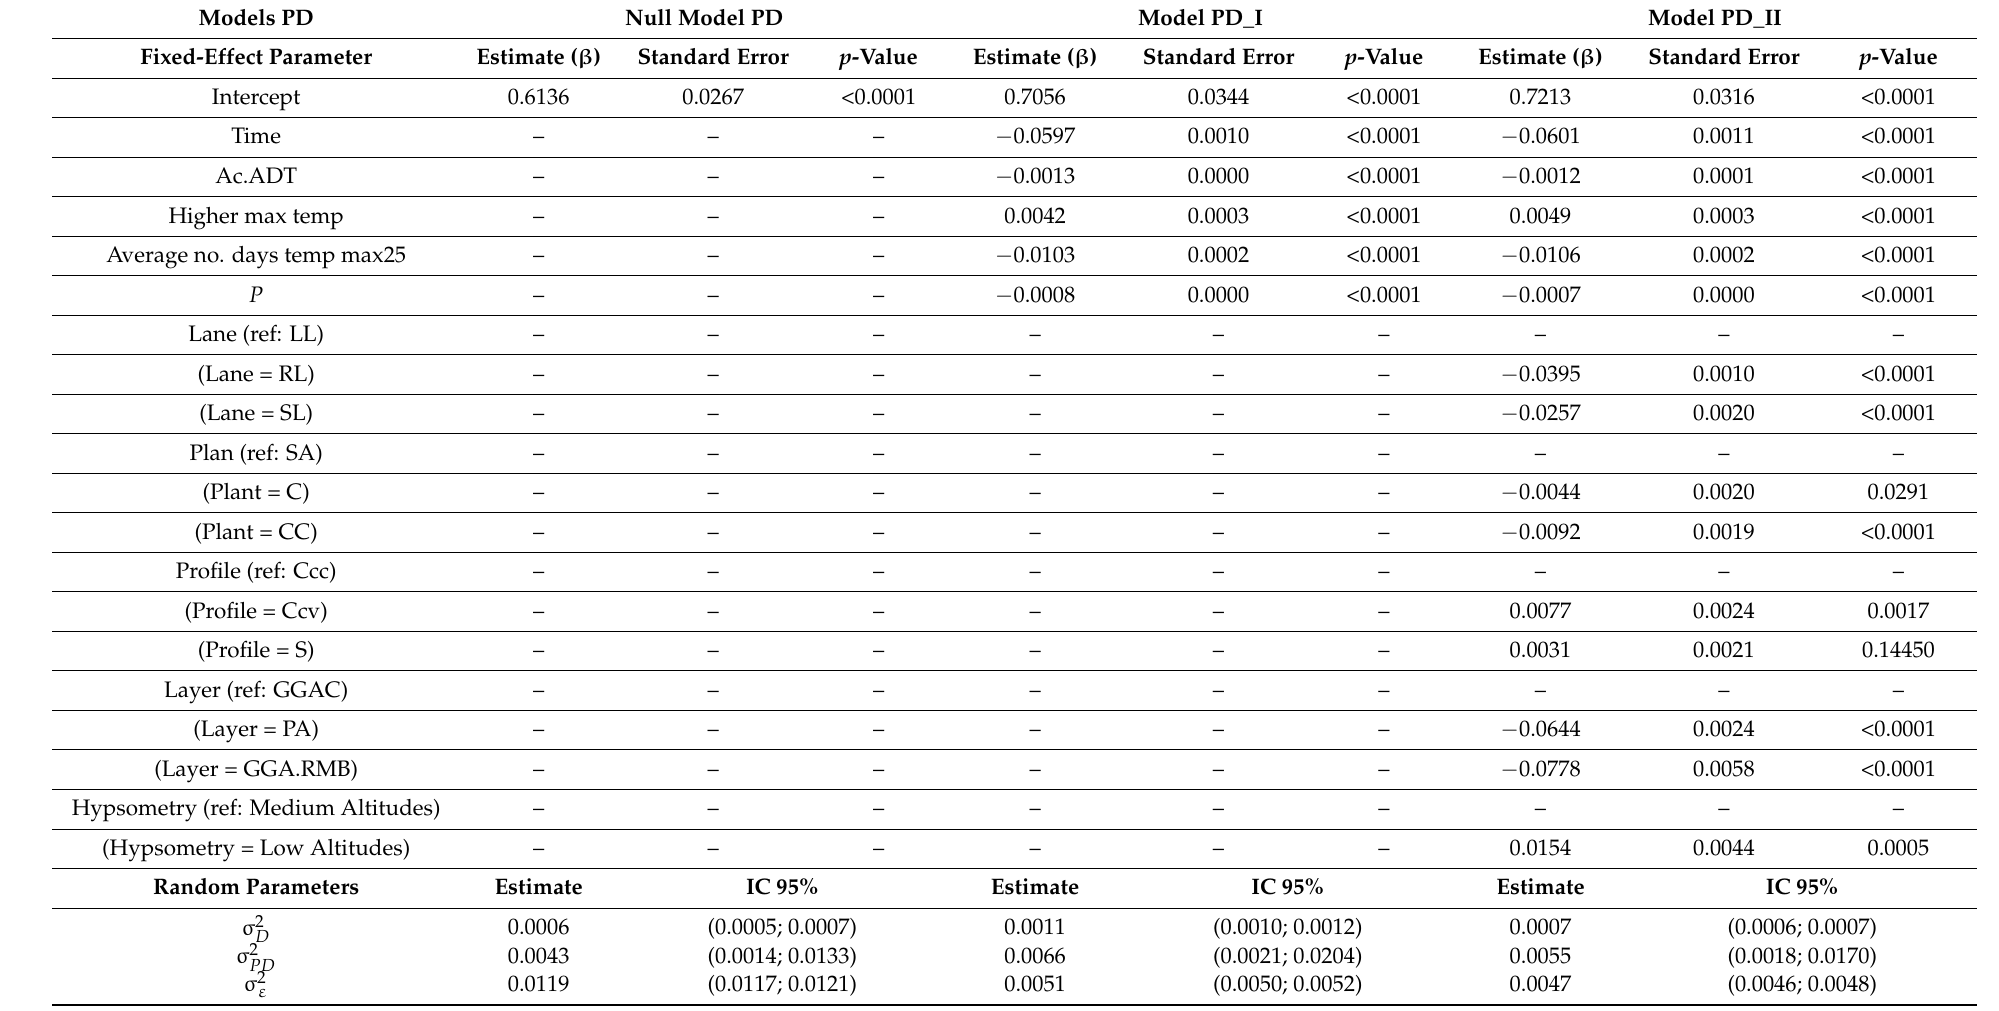
Table 9. Results of the friction models for the three-level